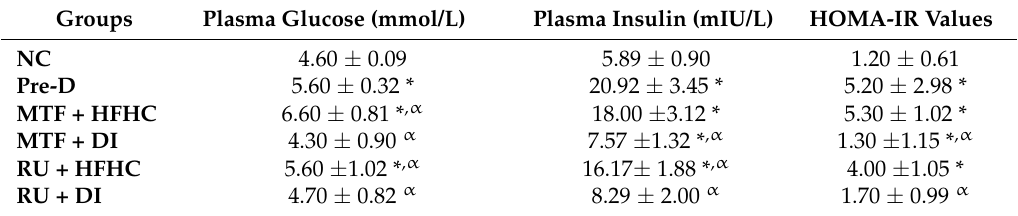
Table 3. Effects of the ruthenium complex on HOMA2-IR index of pre-diabetic animals during treatment period. Values are presented as means ( n = 6) in each group.